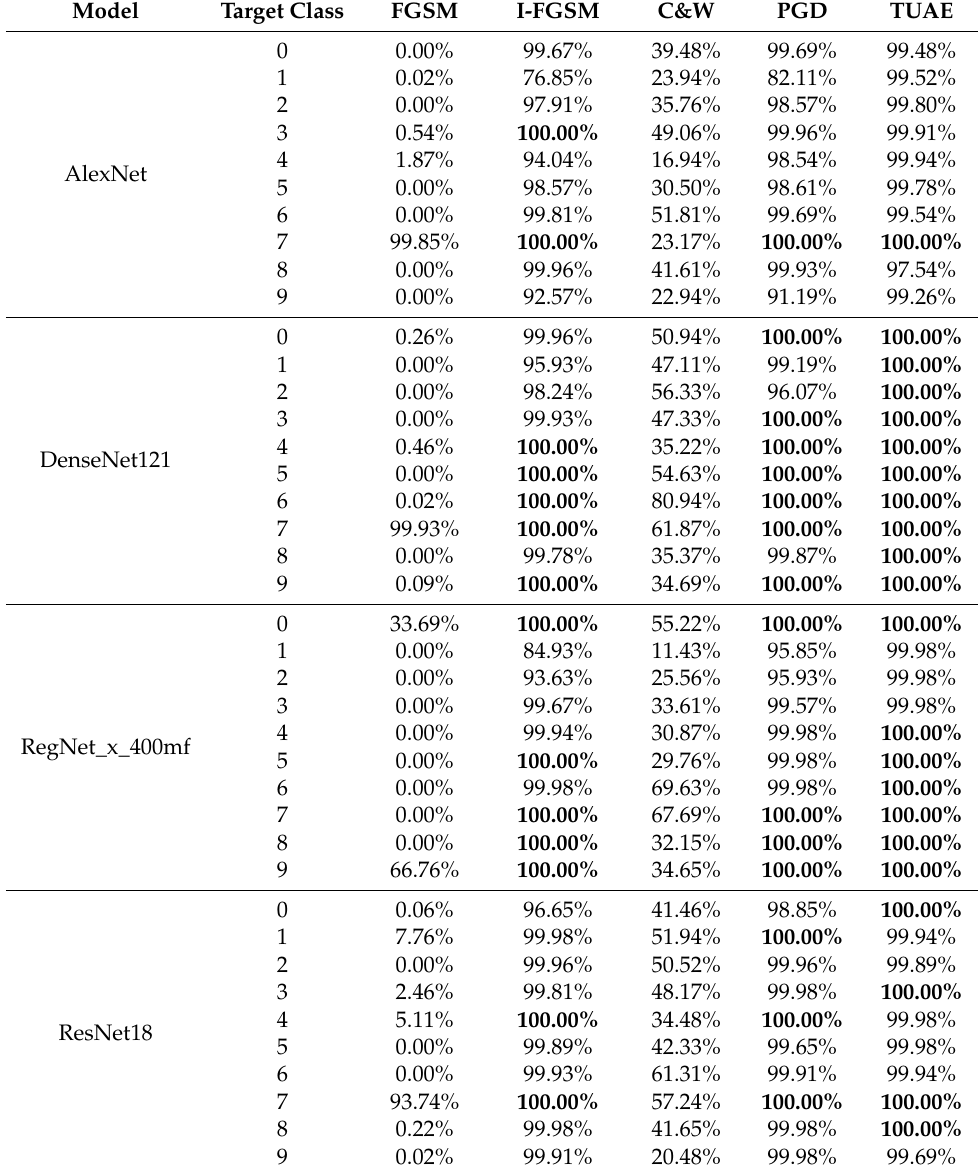
Table 1. Targeted attack success rate(s) (TSR) of various attacks (FGSM, I-FGSM, PGD, C&W, and our TUAE) on EuroSAT data. TSR is defined as # of test samples predicted to Class t . The higher, the better. The # of all test samples highest TSR in every row is in bold